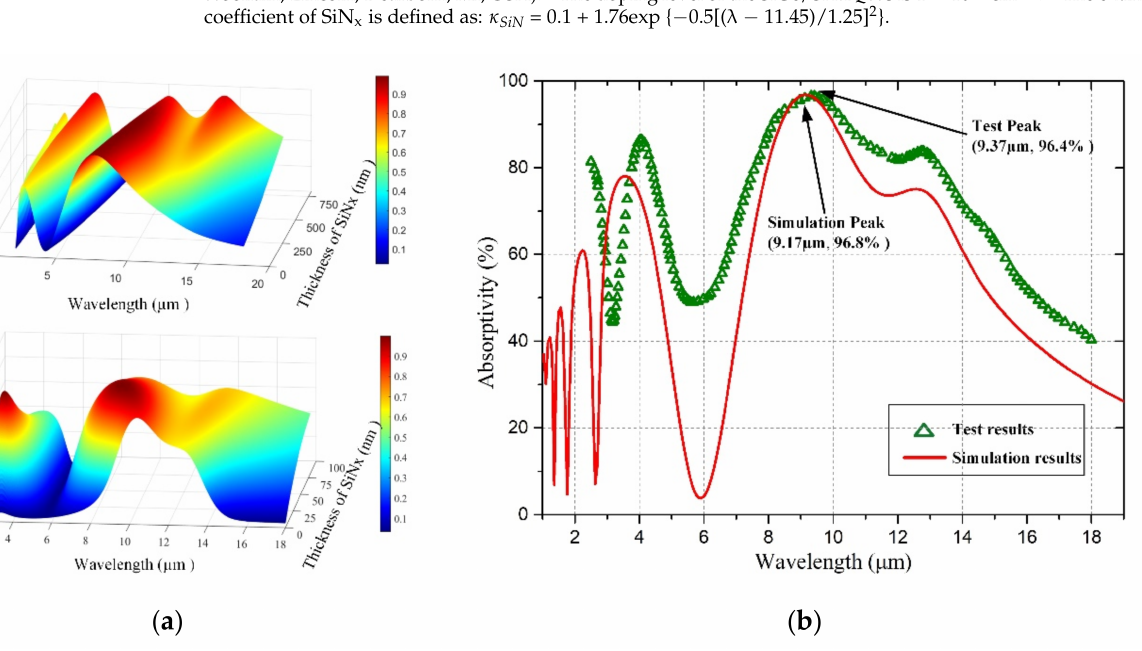
Figure 3. ( a ) The infrared-absorption surface plot of the resonant optical cavity; ( b ) The infrared-absorption simulation results and test results of the resonant optical cavity test